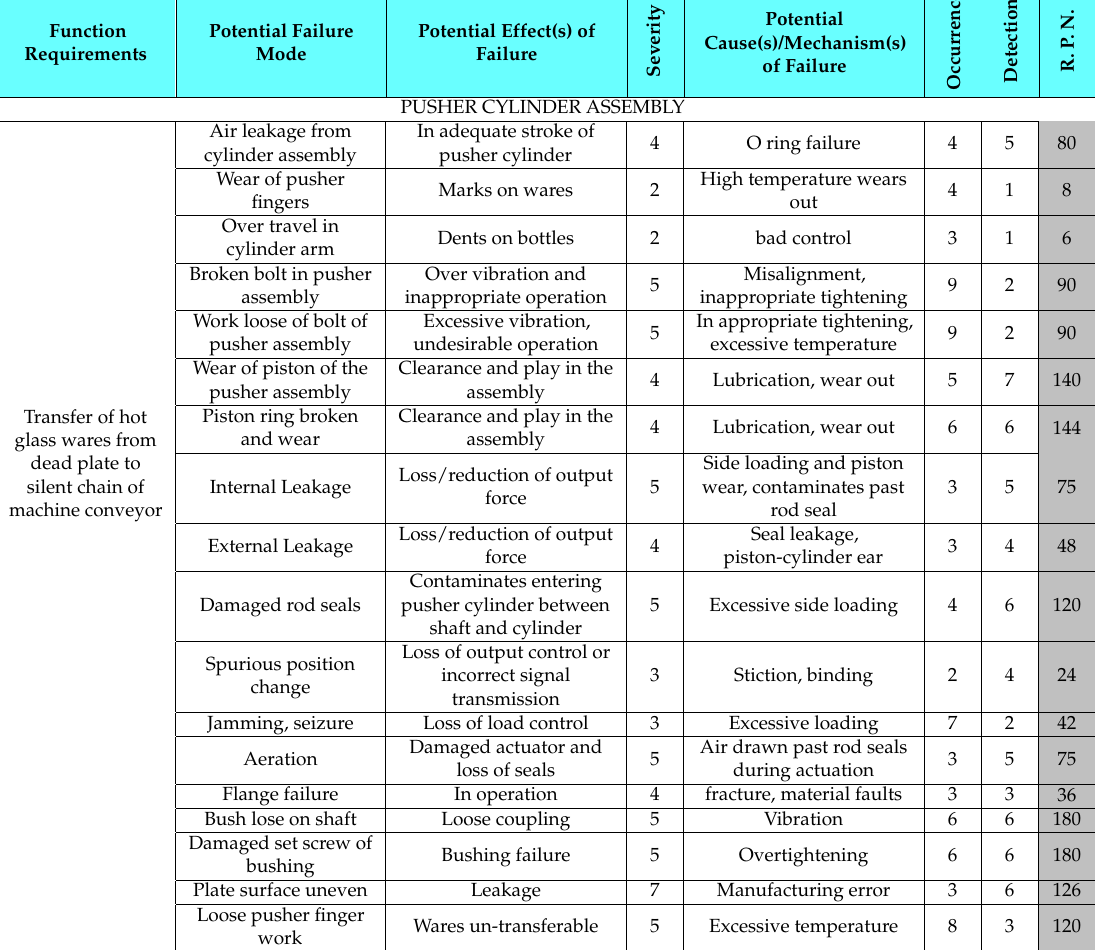
Table 6. Computation of failure modes and effect analysis (FMEA) for pusher